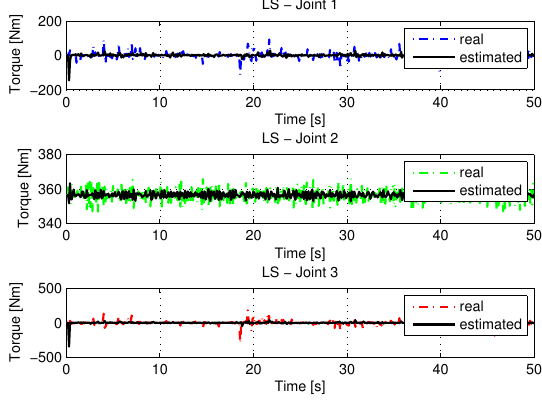
Figure 26. Torque of joints with LS with